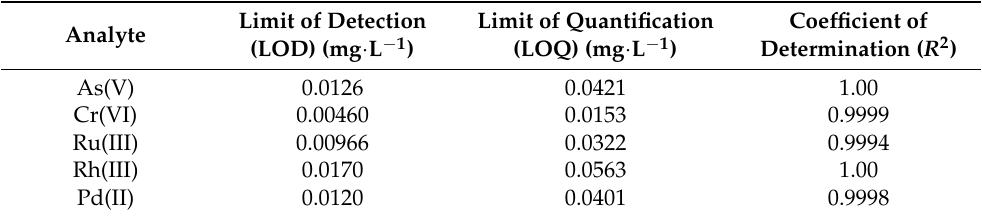
Table 2. The limit of detection (LOD), the limit of quantification (LOQ), and coefficient of determina- tion ( R 2 ) values for the analytes of interest, which include As(V), Cr(VI), Ru(III), Rh(III), and Pd(II). Limit of Detection Limit of Quantification Coefficient of Analyte (LOD) (mg · L − 1 ) (LOQ) (mg · L − 1 ) Determination ( R 2 ) As(V) 0.0126 0.0421 1.00 Cr(VI) 0.00460 0.0153 Ru(III) 0.00966 Rh(III) 0.0170 Pd(II) 0.0120 0.0401